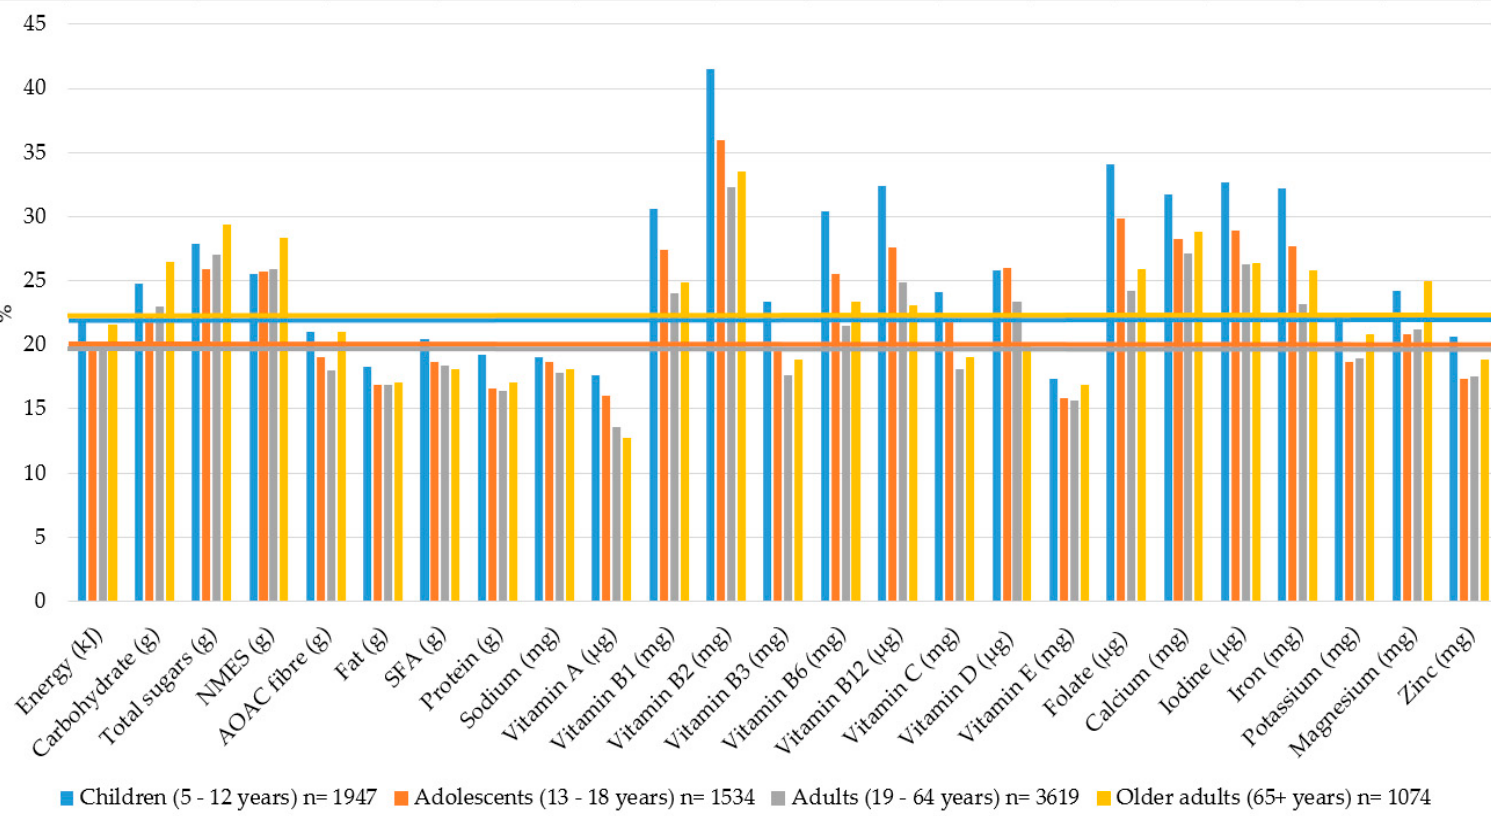
Figure 2. Contribution (%) of breakfast to daily nutrient intakes by age group. Horizontal lines represent the percentage energy contribution from breakfast to total daily energy intake.